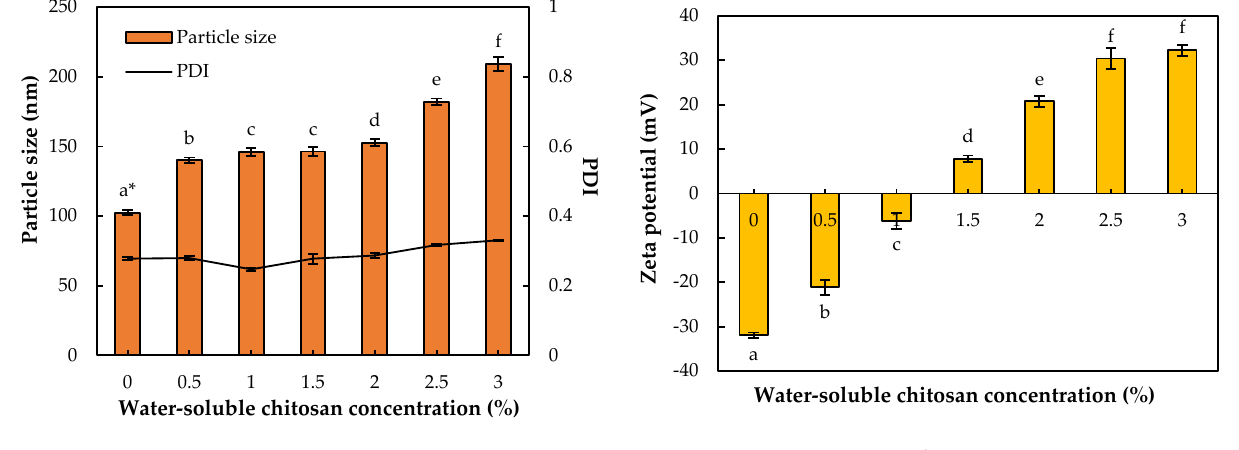
Figure 1. Effect of water-soluble chitosan (WSC) concentration on the physicochemical properties of the WCS-TE-NEs. Each WSC solution was mixed to TE-NE solution in ratio of 1:1 ( w/w ). ( a ) Particle size and PDI; ( b ) zeta potential of the WCS-TE-NEs. * Different letters indicate significant differences at p < 0.05 by Duncan’s multiple range